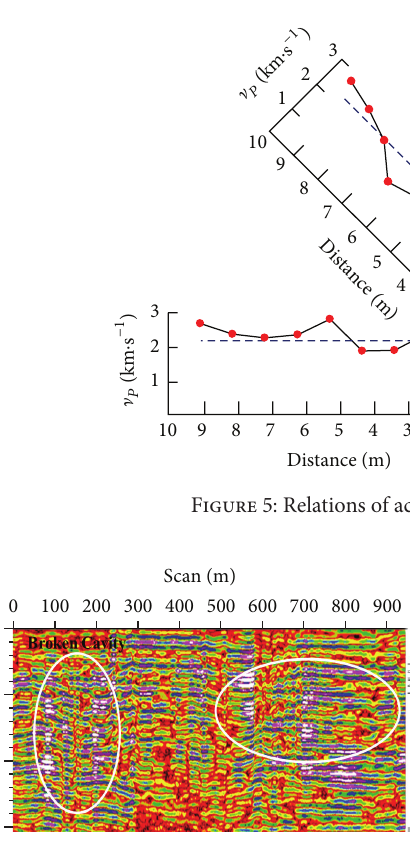
Figure 6: The in situ profile result of the electromagnetic wave. Figure 7: Observation by the borehole optical imaging